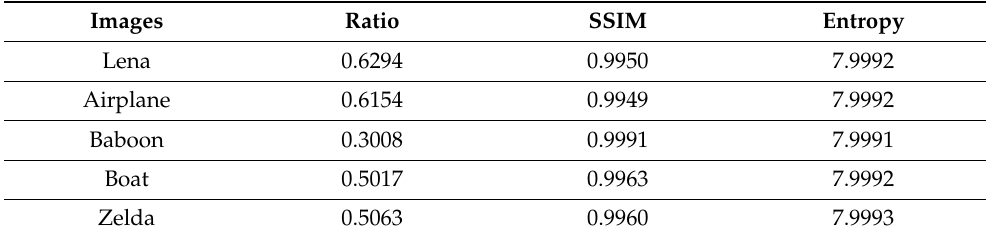
Table 1. Proposed RDH Scheme Output Quality